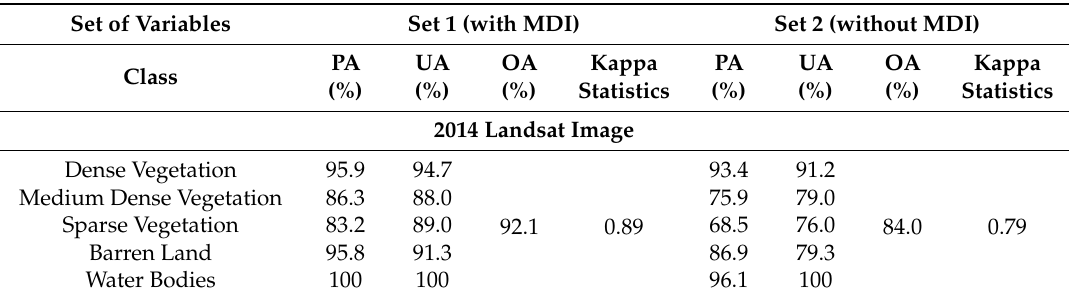
Table 3. Summary of the classification accuracy (%) and Kappa statistics for Set 1 (with MDI) and Set 2 (without MDI) maps.